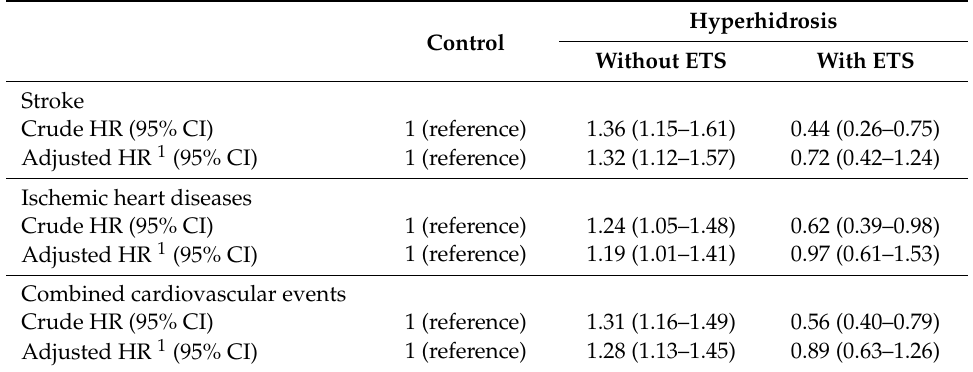
Table 3. Hazard ratio for cardiovascular events according to ETS status determined through Cox regression